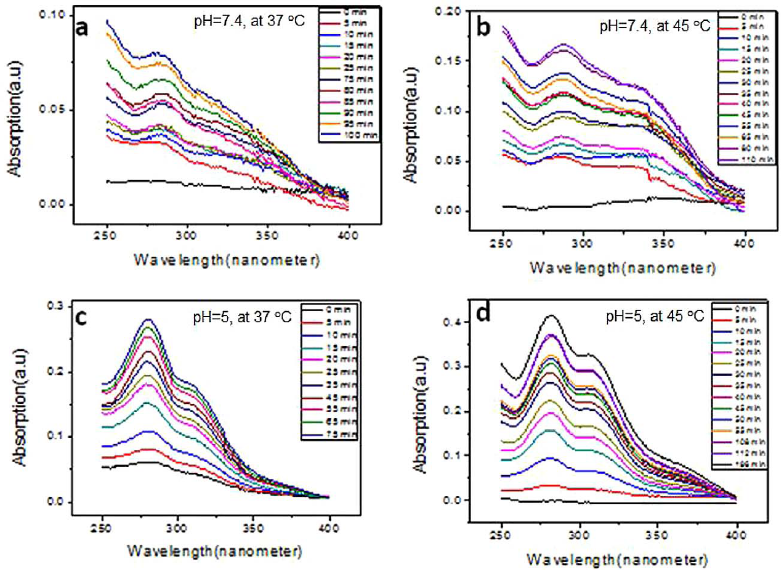
Fig. 4. Release of dopamine from polydopamine loaded HMF-PDA NPs. (a) in pH 7.4 at 37 (cid:1) C, (b) in pH 7.4 at 45 (cid:1) C, (c) in pH 5 at 37 (cid:1) C and (d) in pH 5 at 45 (cid:1)